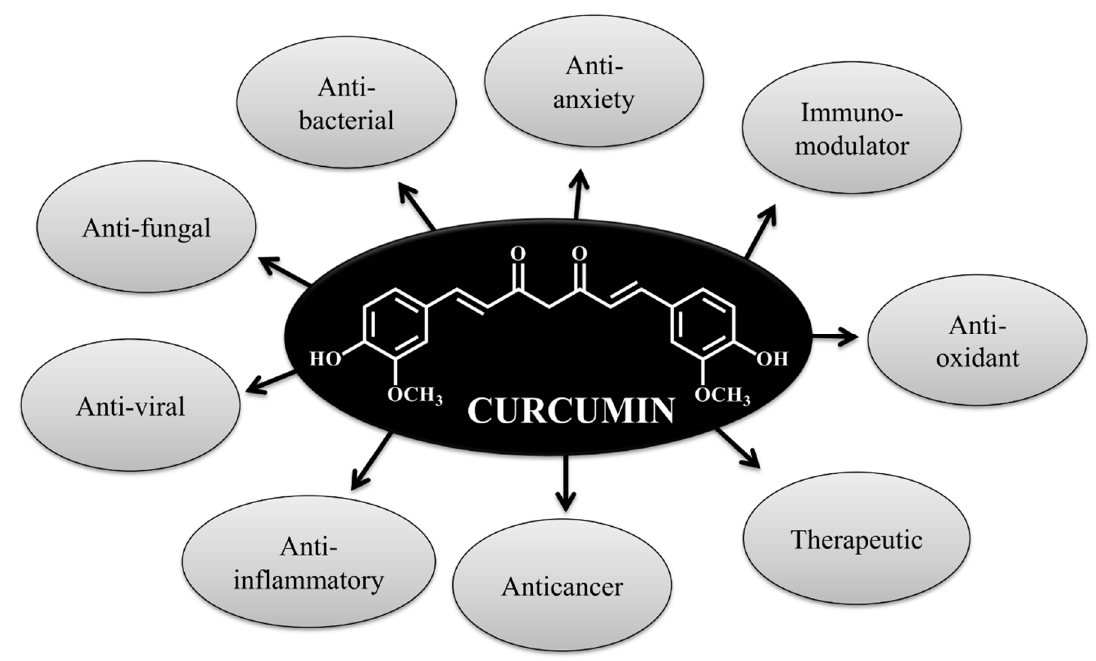
Figure 2. Di ff erent properties of Figure 2. Different properties of curcumin.